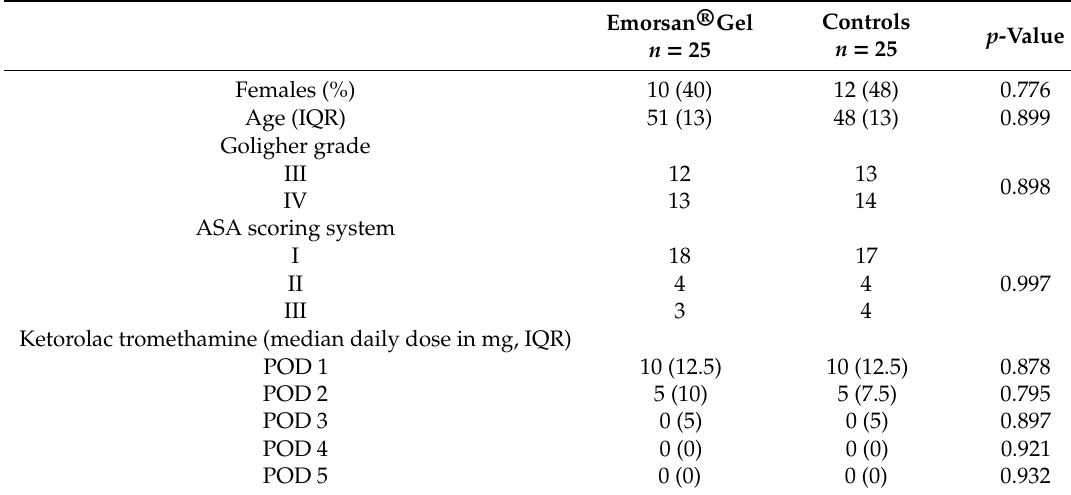
Table 1. Patients’